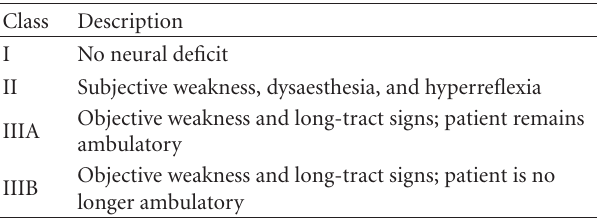
Table 1: Ranawat grading of cervical myelopathy